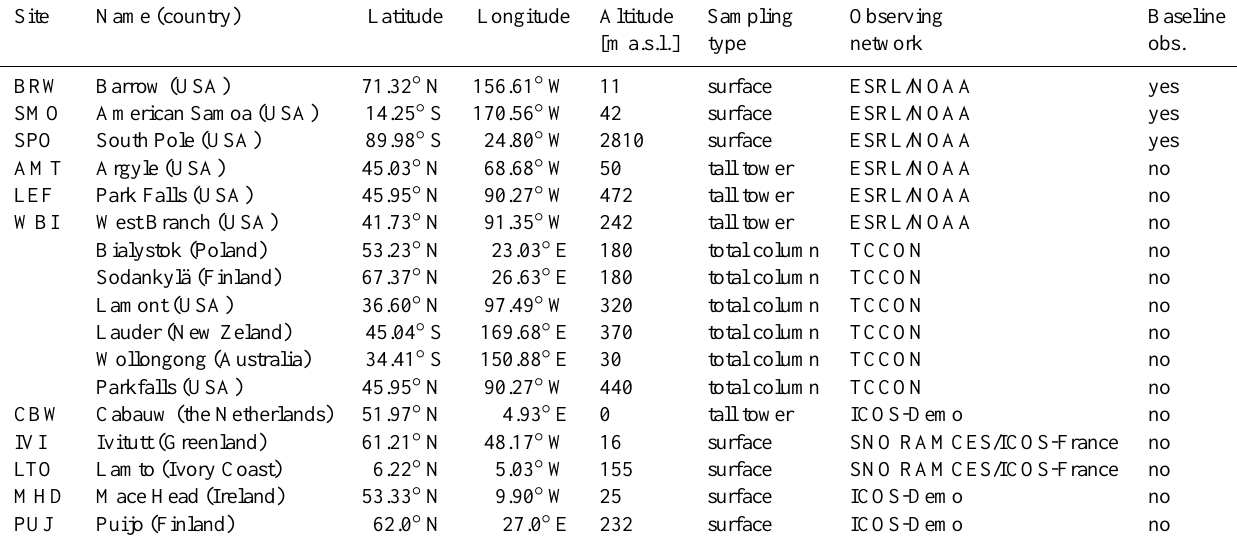
Table 1. Stations with continuous and total column sampling of CO 2 used to evaluate the CO 2 hindcast.